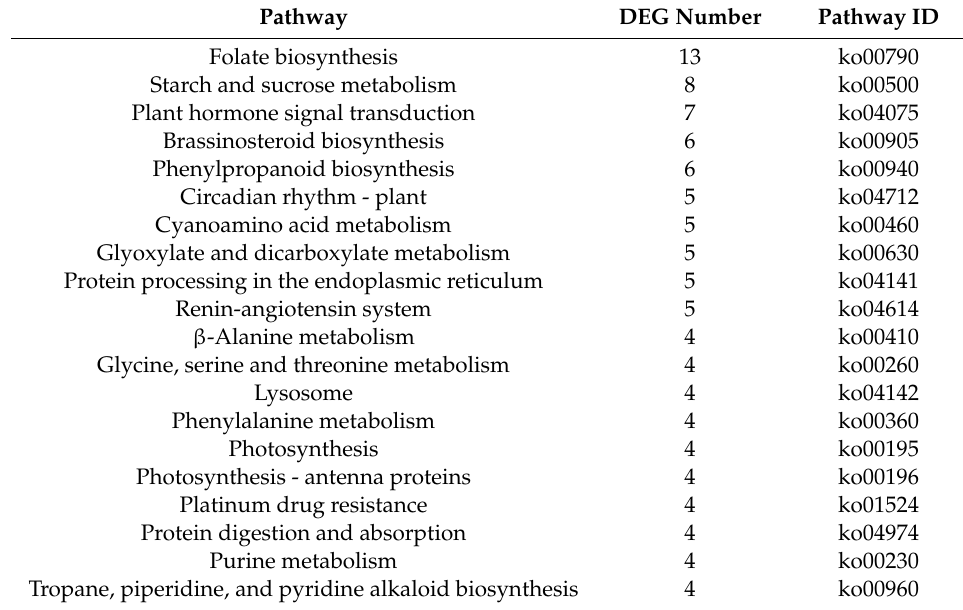
Table 3. Top 20 enriched KEGG pathways of downregulated